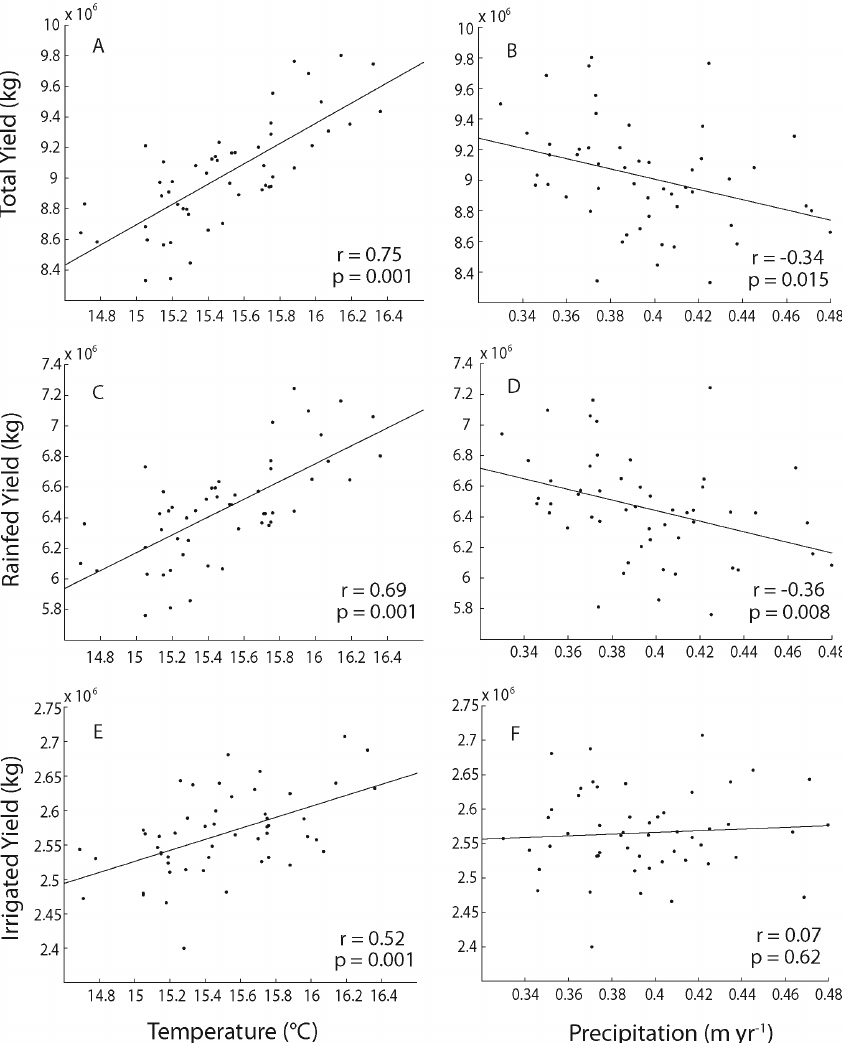
Figure 3. Yield plotted against temperature and precipitation. Total yield ( a and b ) in the Mediterranean increases with increasing temperature and decreases with increasing precipitation. The trend is strongest in regions where agriculture is rainfed ( c and d ). Irrigated regions ( e and f ) also exhibit increased yields with increasing temperature whereas the impact of precipitation is negligible. The reduced yield under higher precipitation is likely related to decreased temperatures under increased precipitation in most of the Mediterranean and thus lower evapotranspiration (Fig. S6). This indicates that the majority of the Mediterranean is temperature-limited for